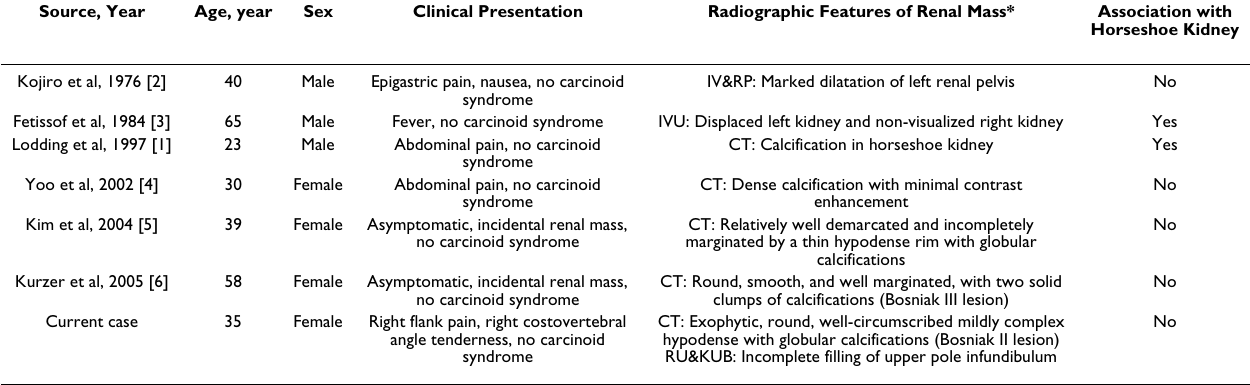
Table 1: Clinical characteristics of primary carcinoid tumor arising within mature teratoma of the kidney Source, Year